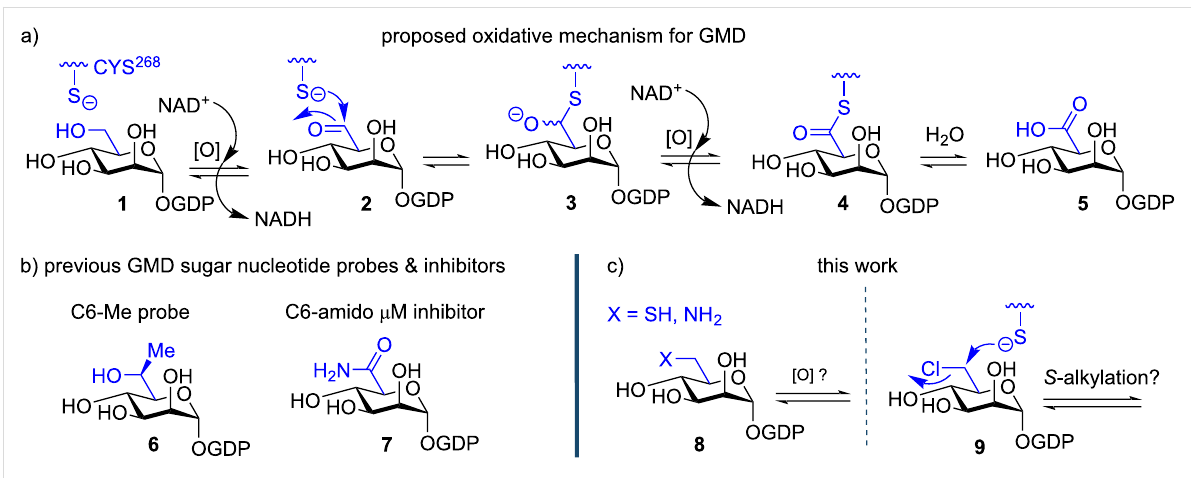
Figure 1: a) Proposed oxidative pathway for provision of GDP-ManA 5 from GDP-Man 1 , C6 stereochemistry of 3 is unknown; b) previously disclosed C6–Me and C6–amido structure-to-function tools for GMD; c) C6-modified GDP-Mans of type 8 and 9 , targeted in this